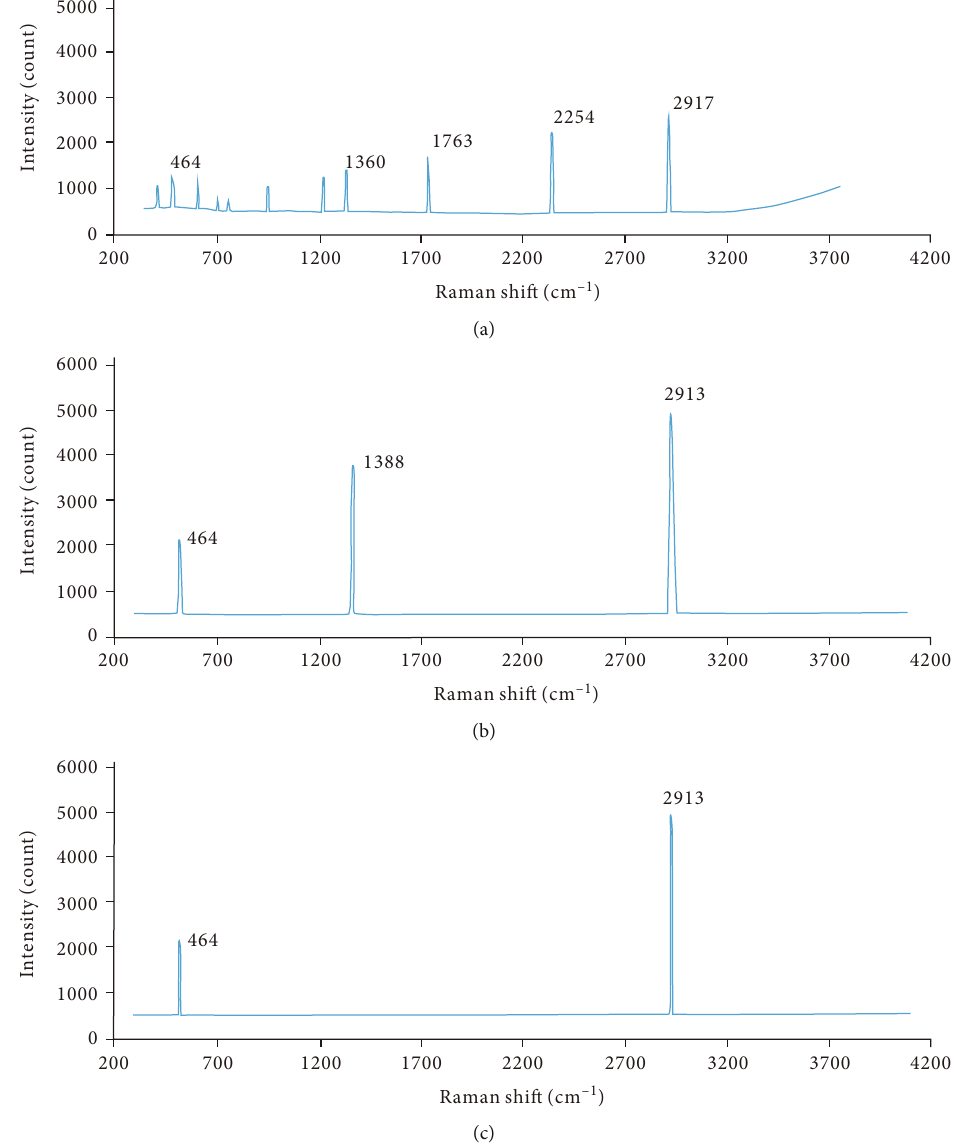
Figure 7: Characteristics of laser Raman spectra of the fl uid inclusions within the Longtan tight sandstones in west Guizhou: (a) saturated hydrocarbon; (b) CH +CO ; (c) CH . 4 2 4